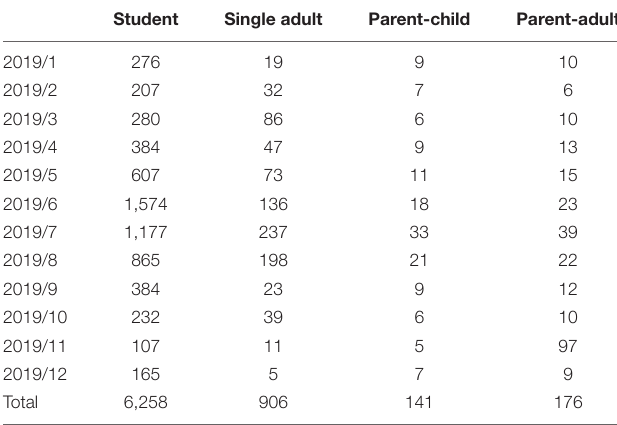
TABLE 3 | Rafting class distribution within the scenic valley visitors.